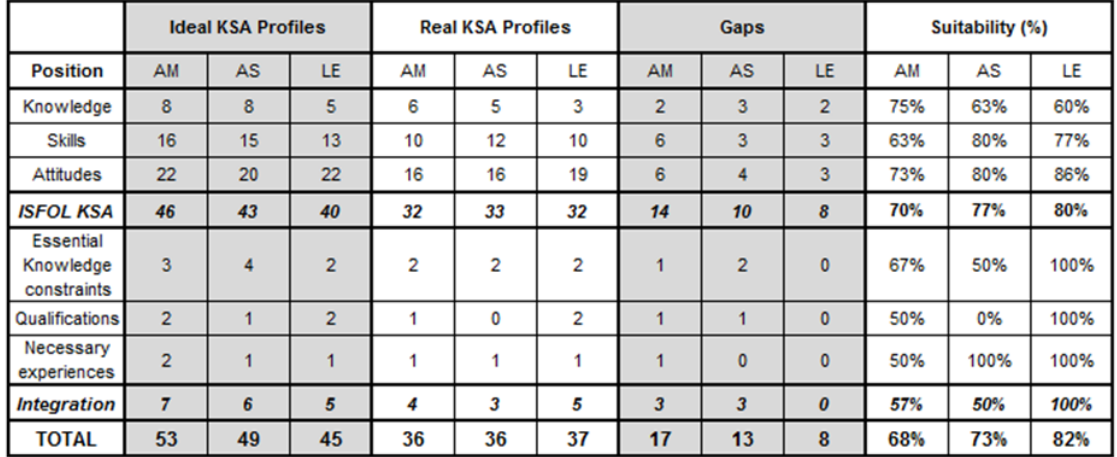
Table 1. Skill gap analysis: results for the different